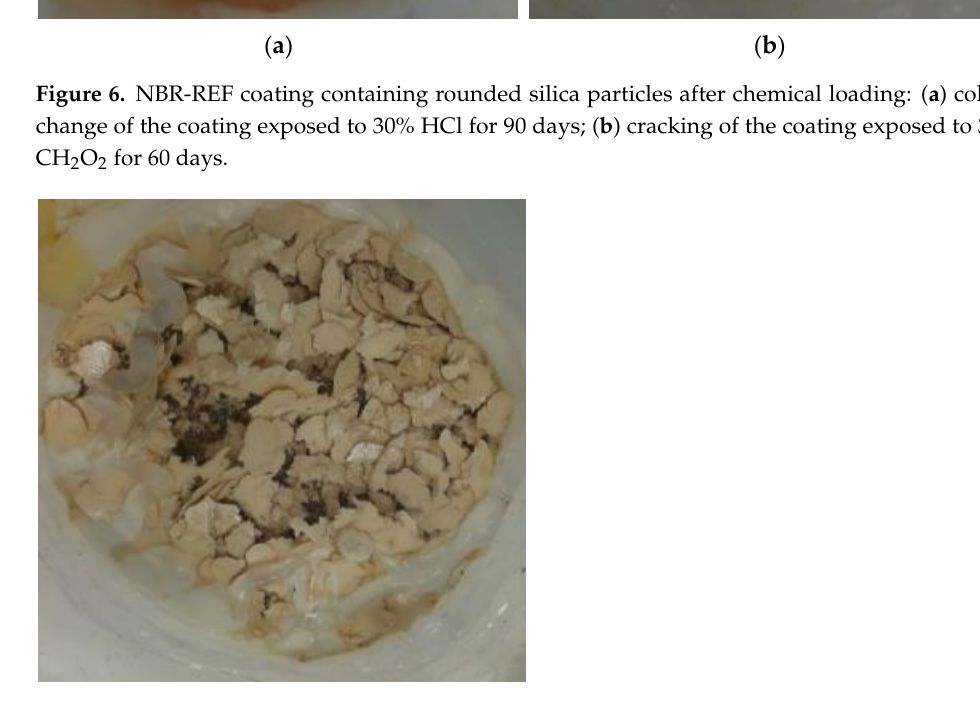
Figure 7. An example of complete degradation of the NBR coating with a filler of rounded particles (NBR-REF) exposed to 30% CH 2 O 2 for 120 days. Table 7. Evaluation of the visual assessment of the chemical resistance of the NBR-GF